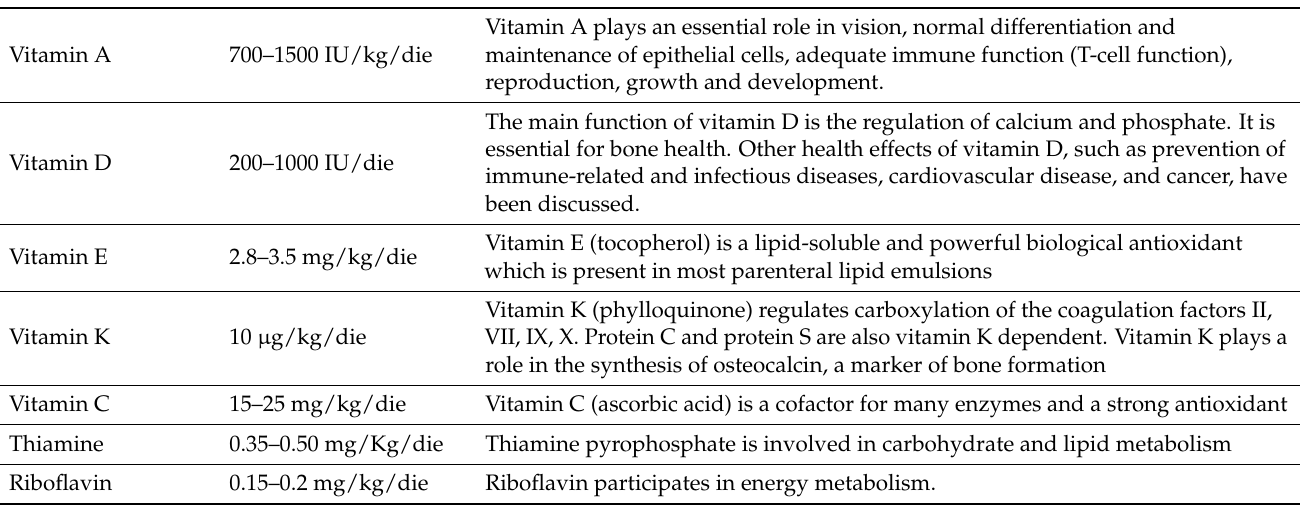
Table 4. Recommended doses for parenteral supply of fat soluble and water soluble vitamins for preterm infants